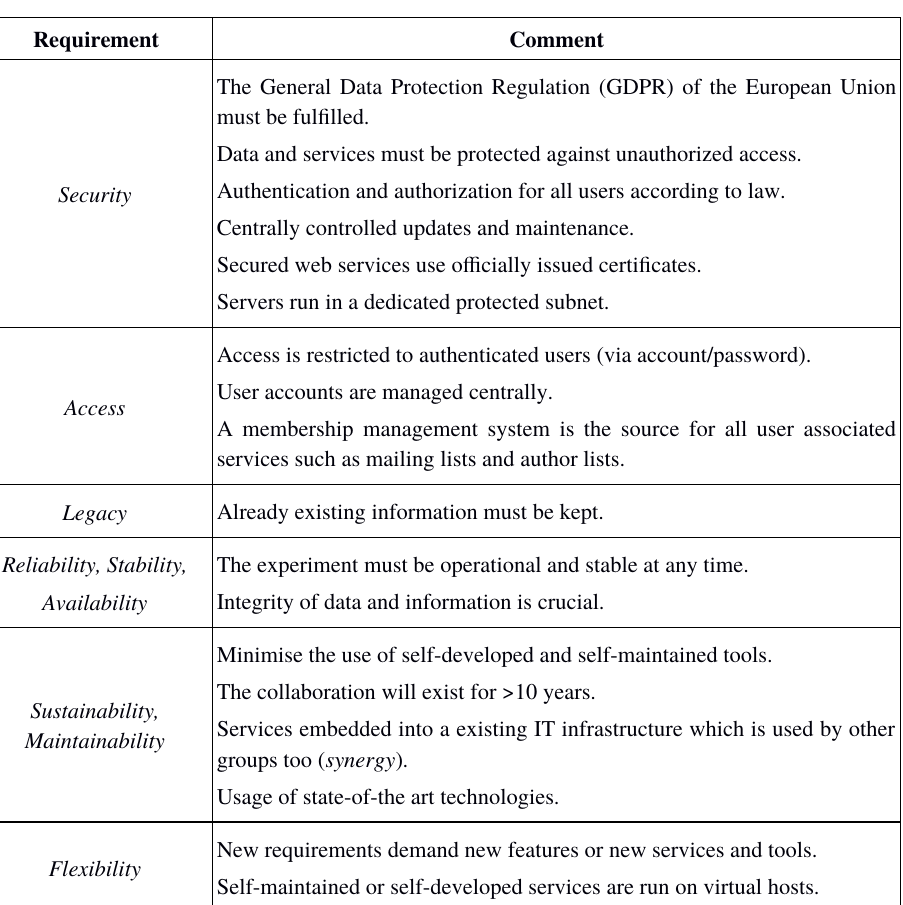
Table 1. Requirements to the collaborative services and